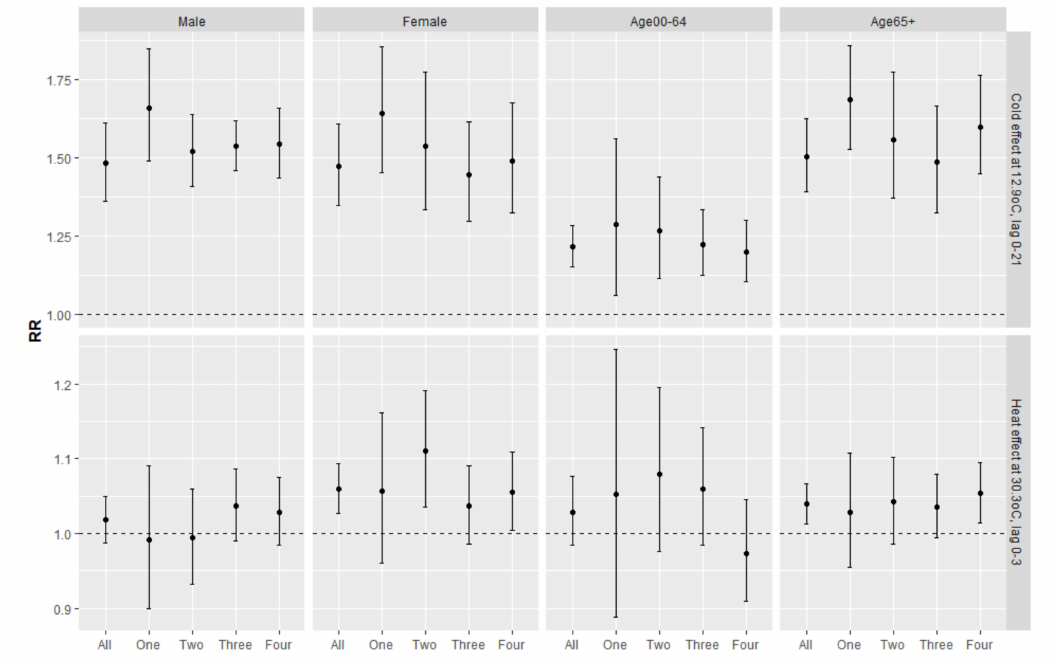
Figure 5. The cold (12.9 ◦ C, 2.5th at lag 0–21) and heat e ff ect (30.3 ◦ C, 97.5th at lag 0–3) on non-accidental deaths compared to 27 ◦ C by age, gender and SES groups where One = the highest SES, Four = the lowest